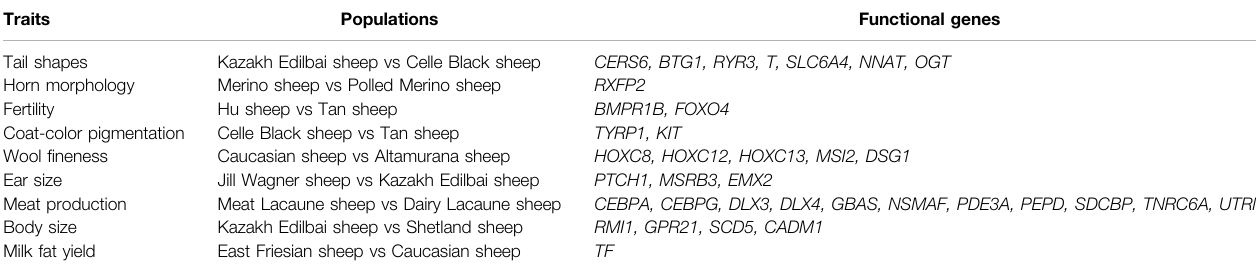
TABLE 2 | Putative genes under selection based on pairwise F ST and XP-CLR. Traits Populations Functional